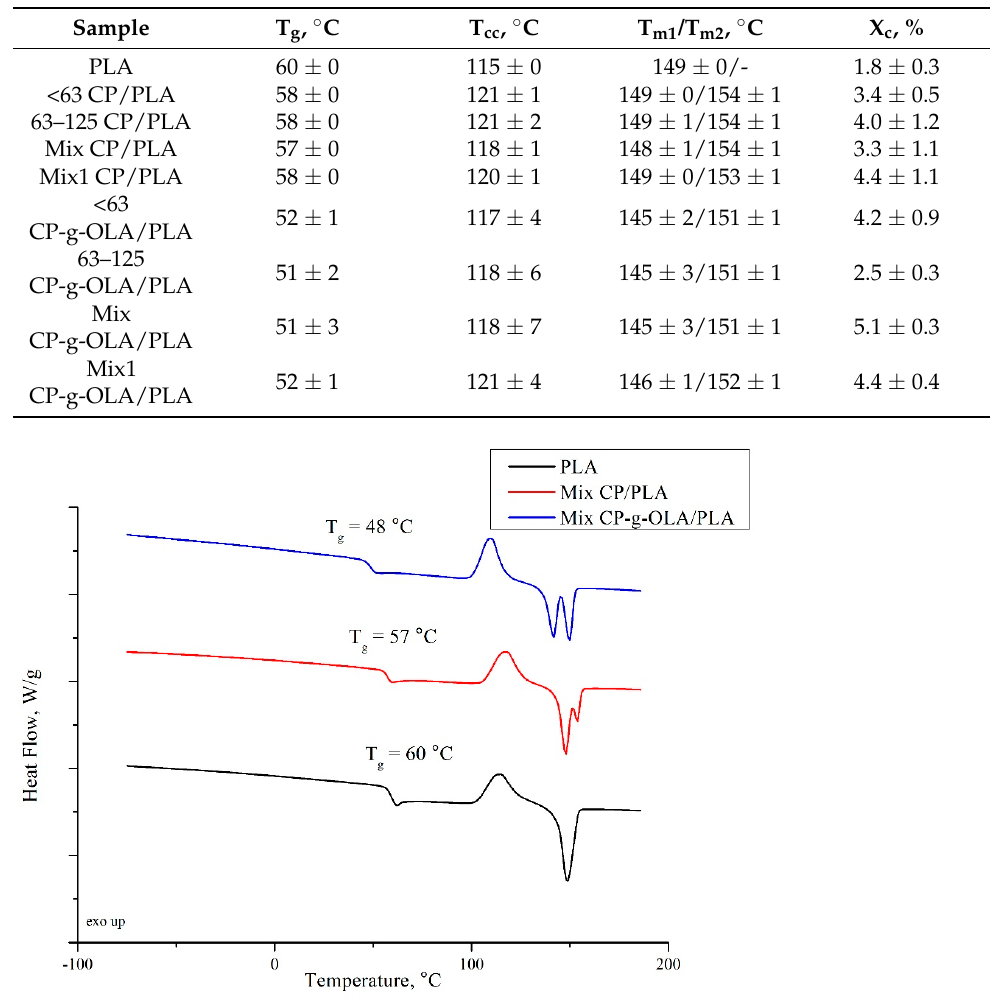
Figure 8. DSC curves of PLA, Mix CP-g-OLA/PLA, and Mix CP/PLA biocomposites.